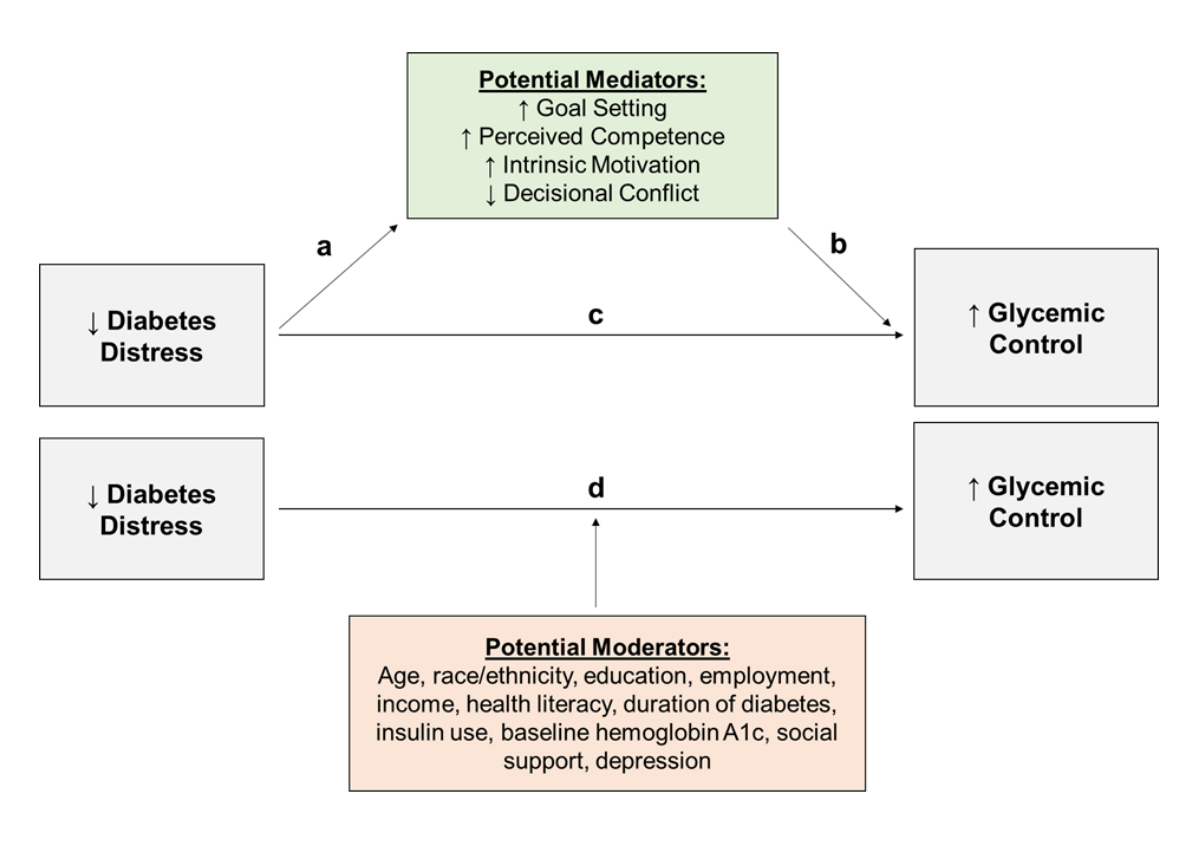
Figure 1. Conceptual model for hypothesized mediators and moderators of improved glycemic control in a peer coaching